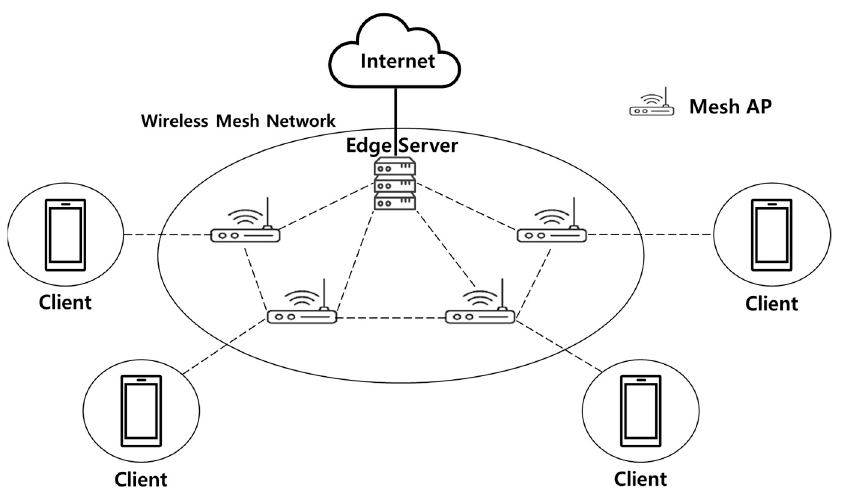
Figure 7. Wireless mesh network topology.